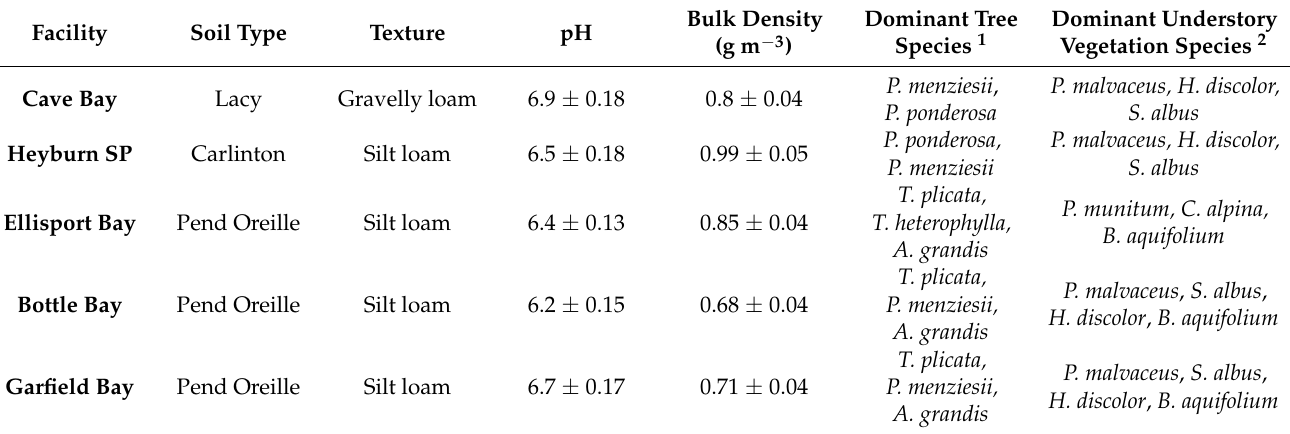
Table 2. Initial soil properties for the top 15 cm of mineral soil depth and facility overstory and understory vegetation